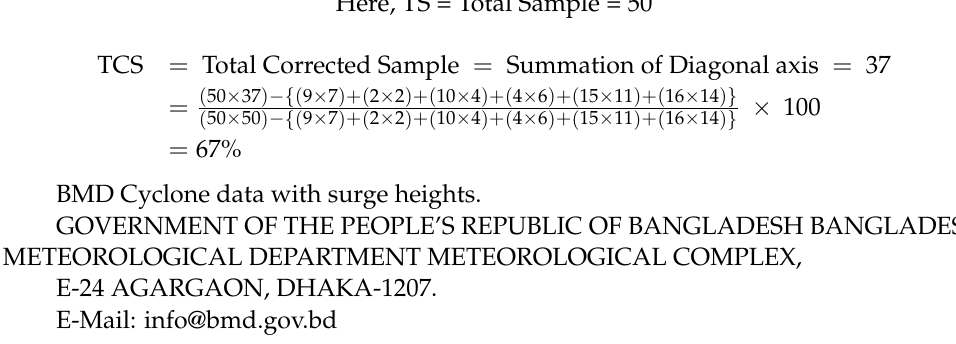
Table A3. List of Major Cyclonic Storms from 1960 to